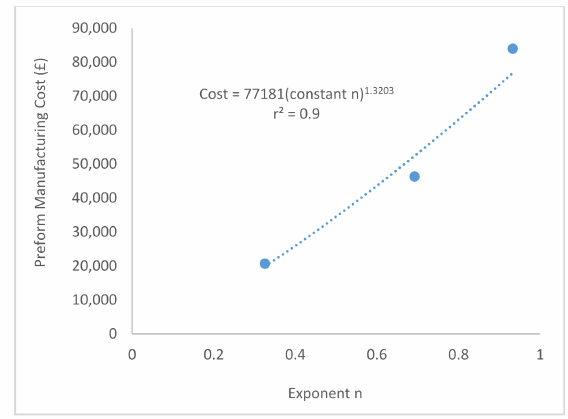
Figure 12. Manufacturing cost vs. complexity